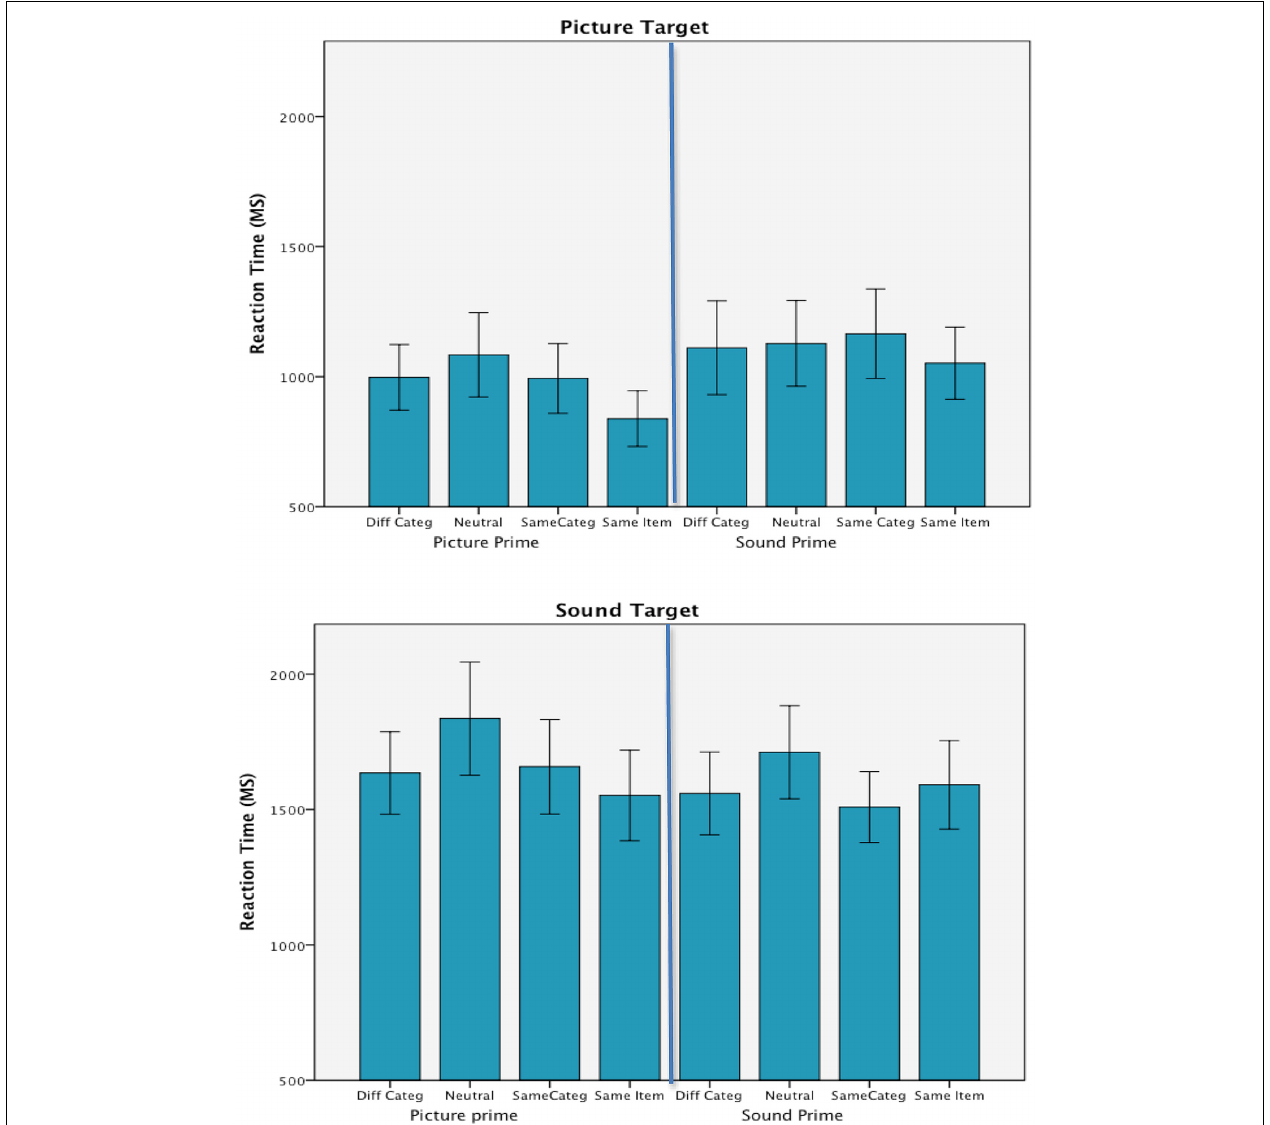
FIGURE 2 | Mean correct reaction times in each of the experimental conditions from Experiment 1. Error bars are 95% confidence intervals.